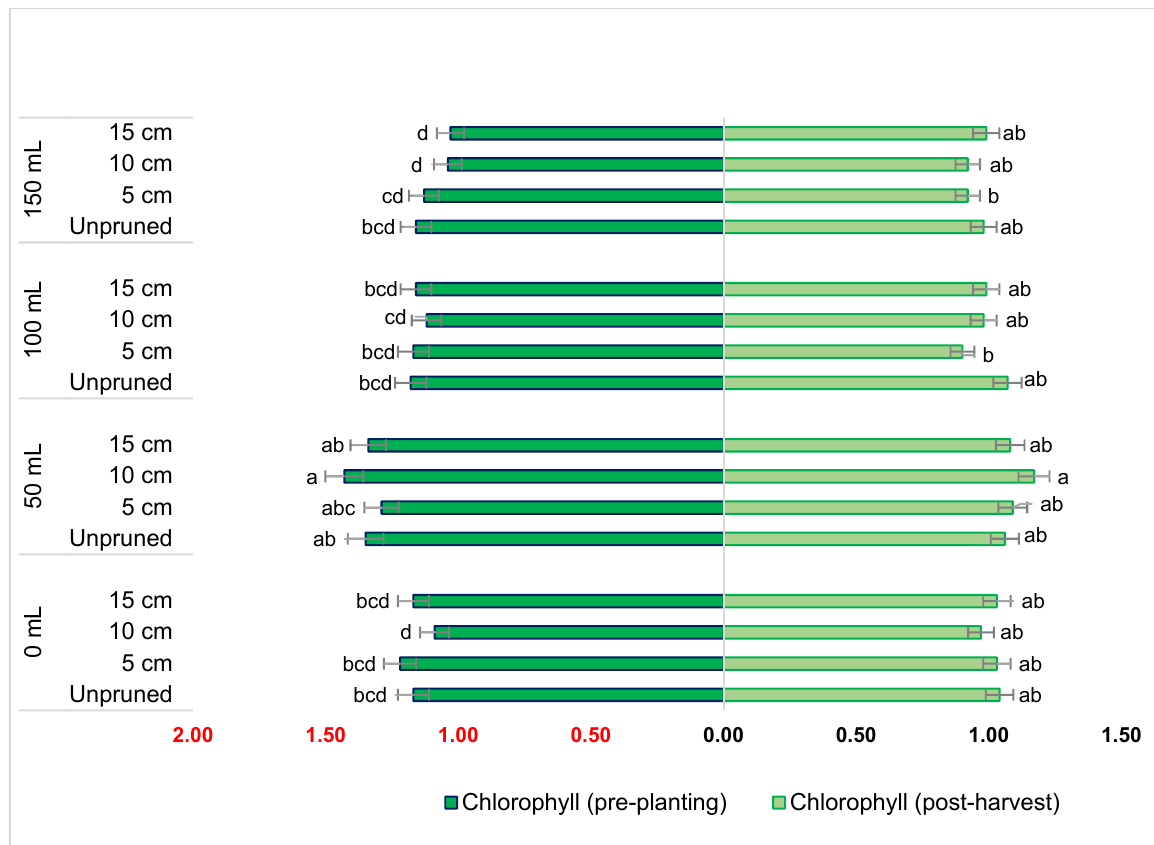
Figure 1. The effect of potassium and pruning levels on chlorophyll content of hydroponically grown T. divaricata. Note: Means that do not share a letter are significantly different at α = 0.05. The potassium dosages of 0 M, 0.0072 M, 0.0144 M and 0.0216 M are respectively equivalent to 0 mL, 50 mL, 100 mL, and 150 mL.